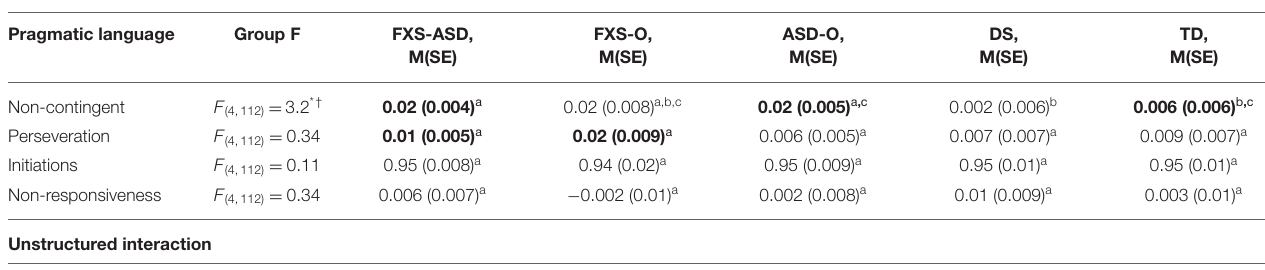
TABLE 4.1 | Group differences in pragmatic language in parents of males. Structured